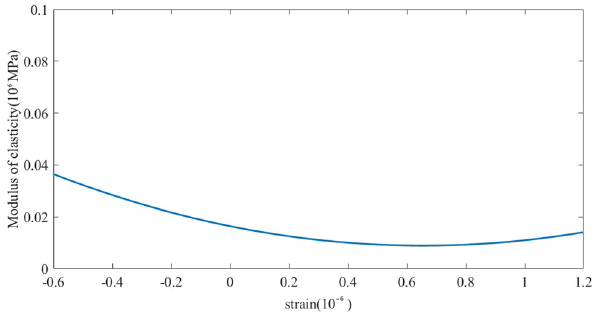
Figure 3: Variation of